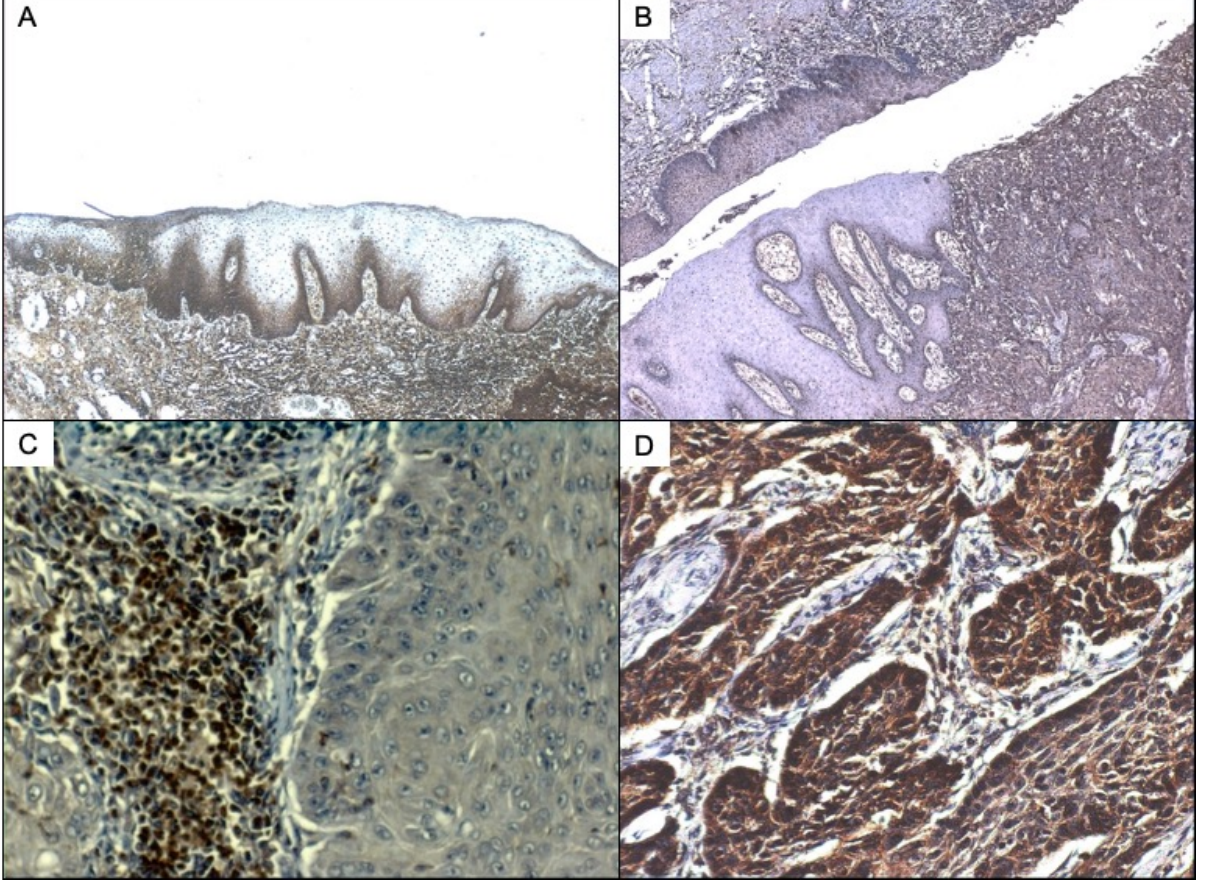
Figure 2. ( A ) SP immunostaining of oral non neoplastic epithelium. SP can be detected in this case both in the membrane of basal keratinocytes and also in the nuclei of subepithelial lymphocytes. The stroma also presents positive inflammatory infiltrate. ( B ) NK1R immunostaining of laryngeal carcinoma and dysplastic epithelium. Strong immunostaining for NK1R can also be detected in the lymphocytes under the basal lawyer of mucosa and tumour infiltrating lymphocytes. ( C ). SP immunostaining of laryngeal carcinoma and dysplastic epithelium with greater increase to show better the infiltrating lymphocytes of dysplastic epithelia. ( D ) SP immunostaining of laryngeal carcinoma showing, under greater zoom, the infiltrating nests expressing SP.